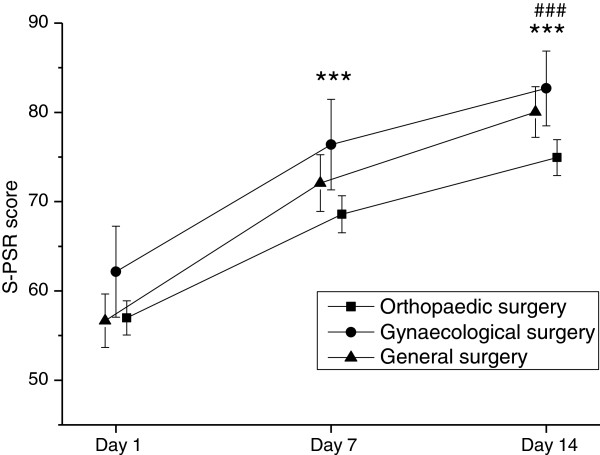
Improvements in recovery between postoperative days 1 to 7,7 to 14 and 1 to 14 in patients undergoing orthopaedic,general and gynaecological day surgery when assessed using the Swedish post-discharge surgery recovery(S-PSR)scale. Means and 95% confidence intervals. *** denotes p<0.001 compared to day 1 and ### denotes p<0.001 compared to day 7 for all three groups separately.